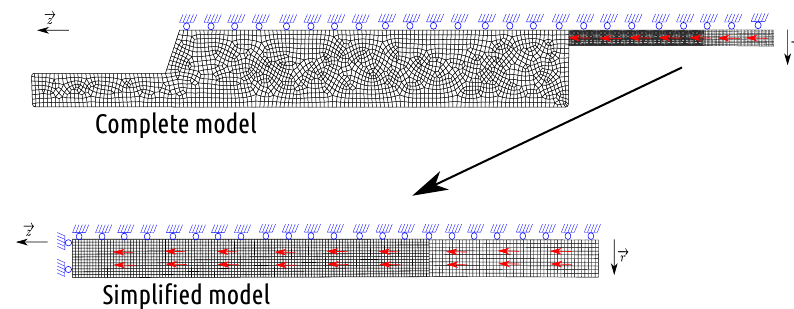
Figure 10. Complete and simplified Taylor